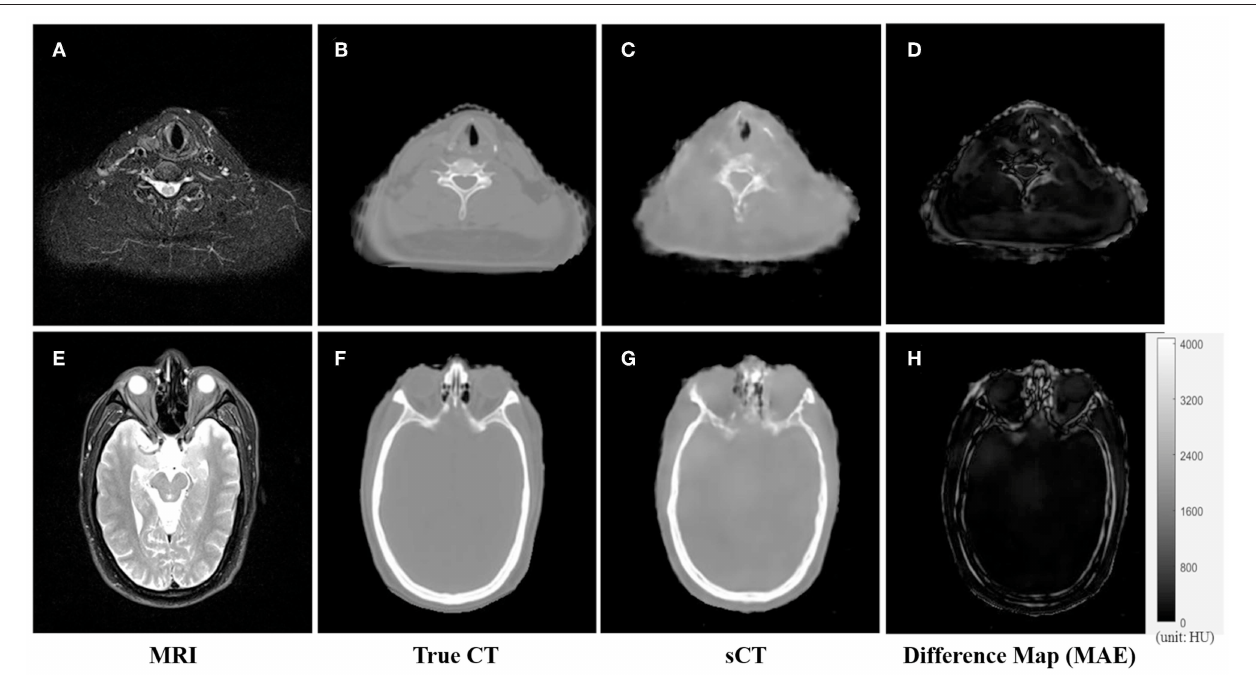
FIGURE 3 | The comparison of CT and synthetic CT for two representative MR images. (A) MR image in the neck region; (B) real CT image aligned with (A) ; (C) synthetic sCT converted from MR image (A) ; (D) difference map between (B,C) ; (E) MR image in the head region; (F) real CT image; (G) synthetic sCT image; (H) difference map between (F,G) . Gray bar in (H) indicated the mapping from CT number to gray scale in the difference